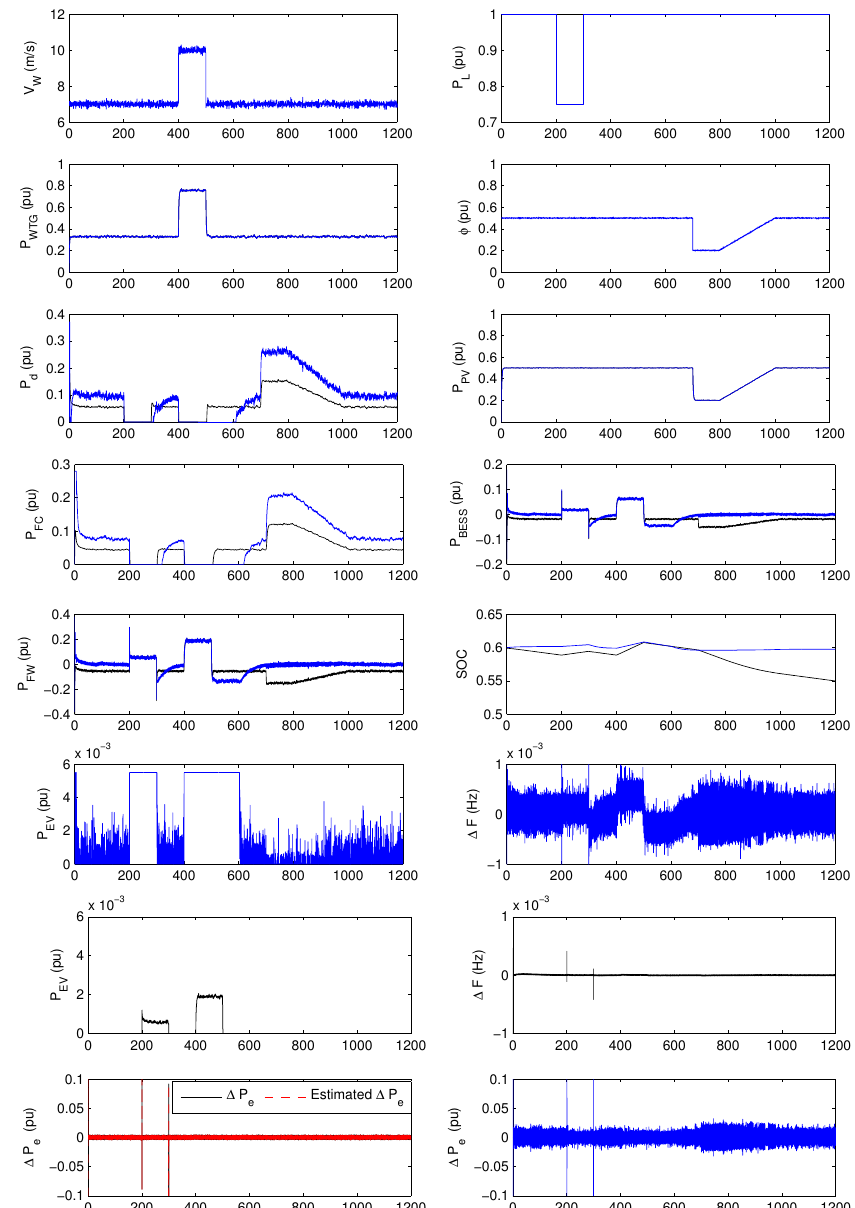
Figure 8. Case 1 simulation results: proposed (black) and conventional